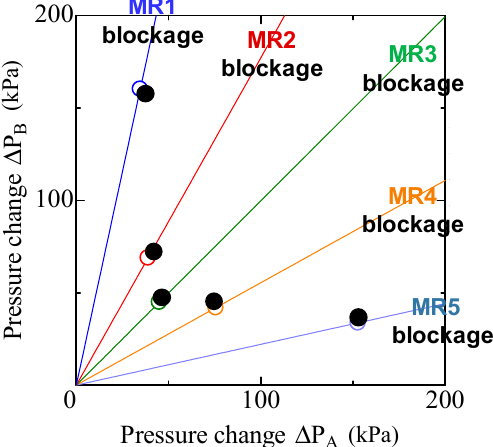
Figure 10. Result of blockage detection and diagnosis. Closed and open circles correspond to the experiment and pressure drop compartment (PDC) model-based simulation, respectively.